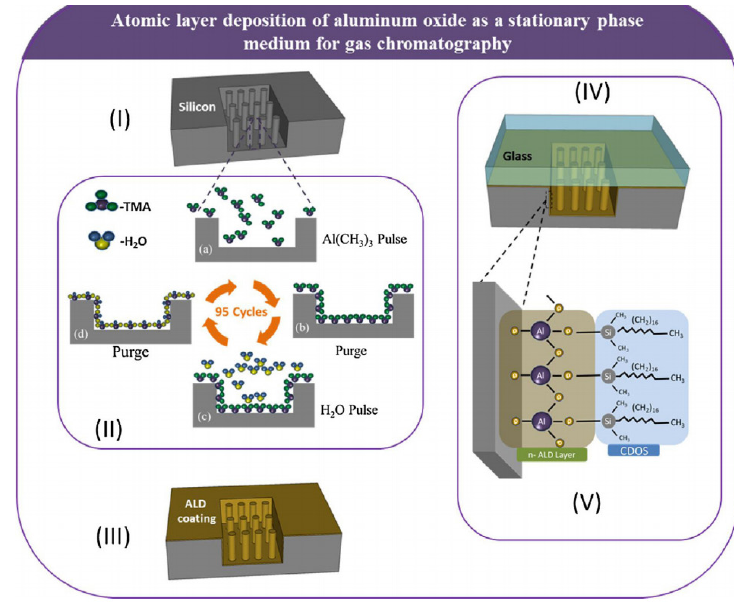
Figure 7: Schematic diagram of MEMs column prepared by chemical vapor